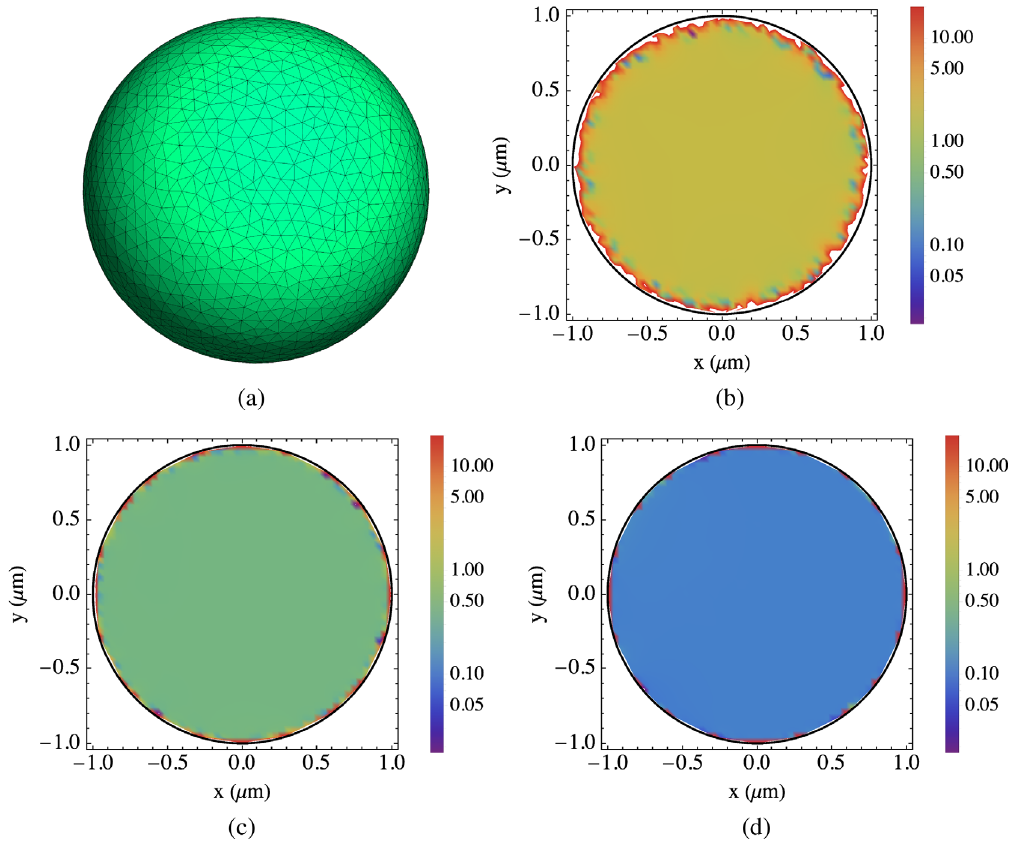
FIG. 4. Visualization of the discretized boundary for the sphere (a) with 3 × 10 3 elements. Density plots of the percent error in the electric potential in a cross section of the sphere using 1 × 10 3 (b), 3 × 10 4 (c), and 6 × 10 5 (d) boundary